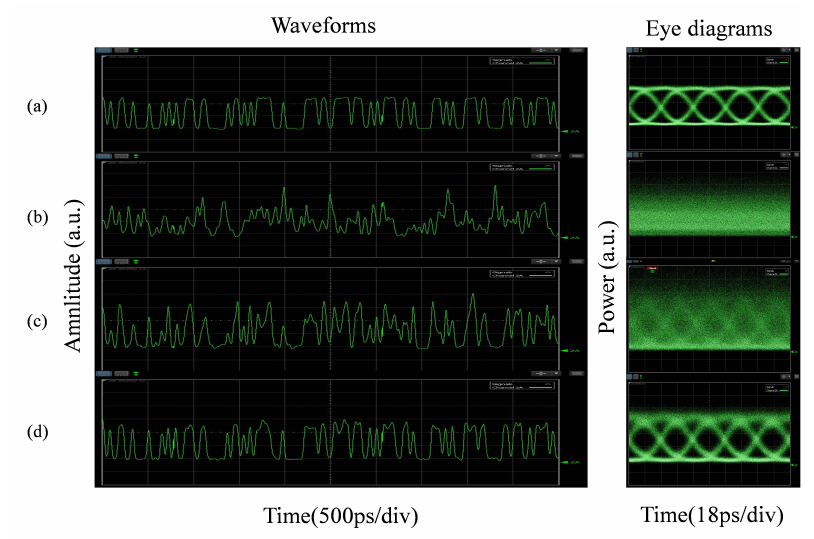
Figure 5. Waveforms and eye diagrams for ( a ) the original signal ( b ) intercepted encryption signal and ( c , d ) the recovered signals using a TDS matched reconstructed decryption module without and with proper D3 and